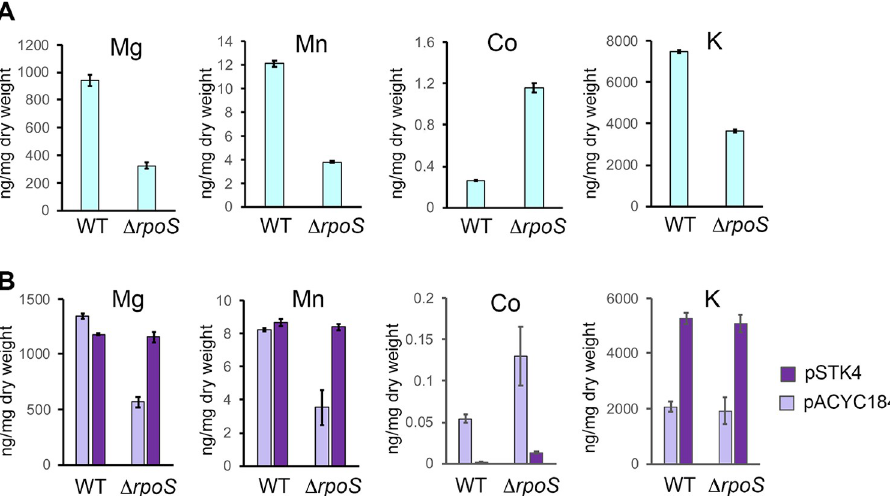
Fig 5. Effect of the Δ rpoS mutation on the Salmonella ionome in stationary phase. Quantification of cell-associated concentration of elements in Salmonella , grown to stationary phase in LB rich medium, was performed by inductively coupled plasma mass spectrometry (see Methods). Three biological replicates were analyzed in duplicate each. A complete set of data is provided in S1 Dataset. (A) Data are shown for element contents showing significant differences (p < 0.05, fold-change > 2) between the wild type strain (WT, VF6910) and the Δ rpoS mutant (VF8158): Magnesium (Mg), manganese (Mn), cobalt (Co) and potassium (K). (B) Complementation experiments with the cloned rpoS gene on pSTK4. The empty vector pACYC184 was used as a control. Error bars display the standard error of the mean for the three independent replicates (A, B).